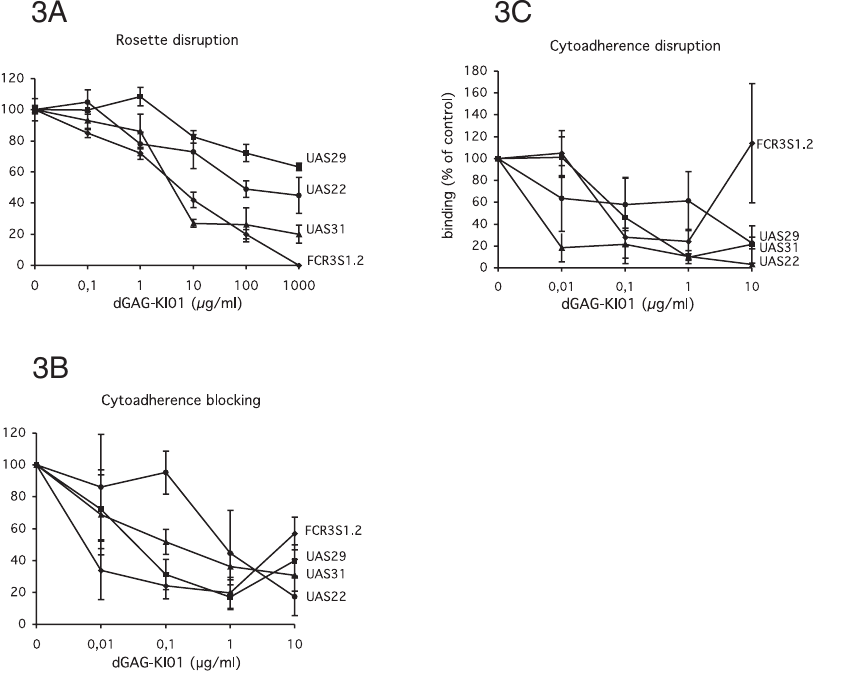
Figure 3. Effect of dGAG-KI01 on P. falciparum Rosettes and Cytoadherence of IE In Vitro (A) Aliquots of rosetting parasite cultures (UAS22, UAS29, UAS31, and FCR3S1.2) were treated with dGAG-KI01 at different concentrations. The rosetting rates were counted after 30-min incubation and compared with mock-treated samples. (B) and (C) For the cytoadherence assays, different P. falciparum IE (UAS22, UAS29, UAS31, and FCR3S1.2) were allowed to attach to rat lung sections under orbital shaking (50 rpm) at 37 8 C. Different concentrations of dGAG-KI01 were added together with IE (B) or after letting the IE adhere (C). Unbound material was removed by washes before the slides were fixed in glutaraldehyde, stained with Giemsa, and analyzed by light microscopy at a 1,000 3 magnification. DOI: